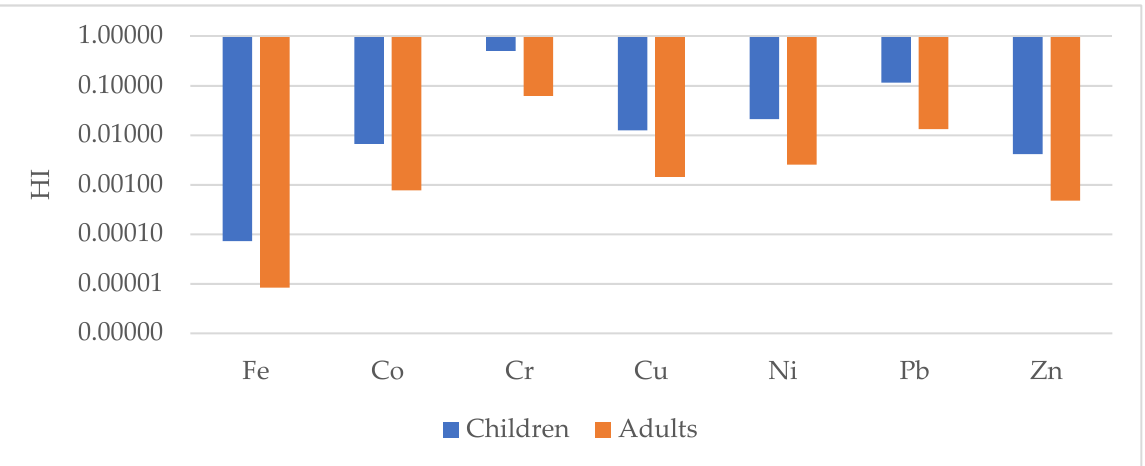
Figure 14. Non-carcinogenic risk hazard index (HI) for children and adults for selected metals in the studied geophagic clays in Cameroon.